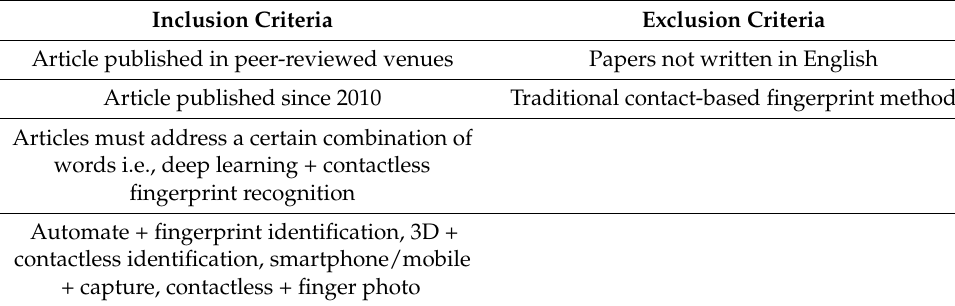
Table 1. Inclusion and Exclusion Criteria for this systematic